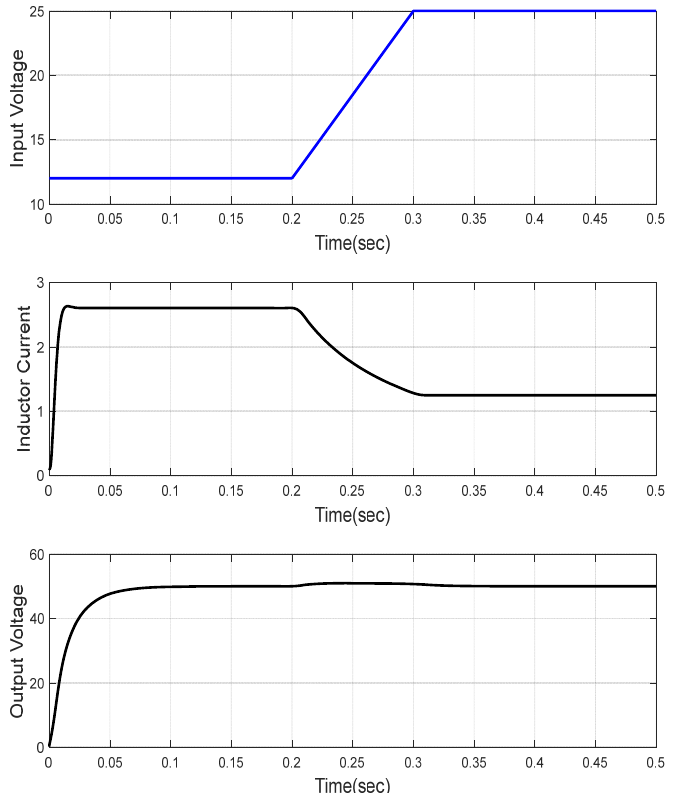
Figure 28. The behaviour of the inductor current and output voltage in case of input voltage changes and in the presence of measurement noise.